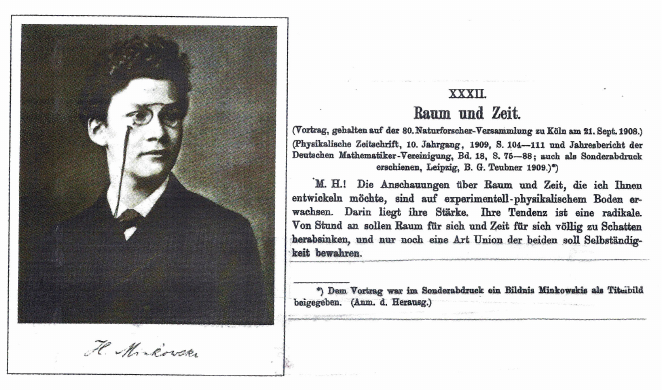
Figure 1. From Minkowski’s “Raum und